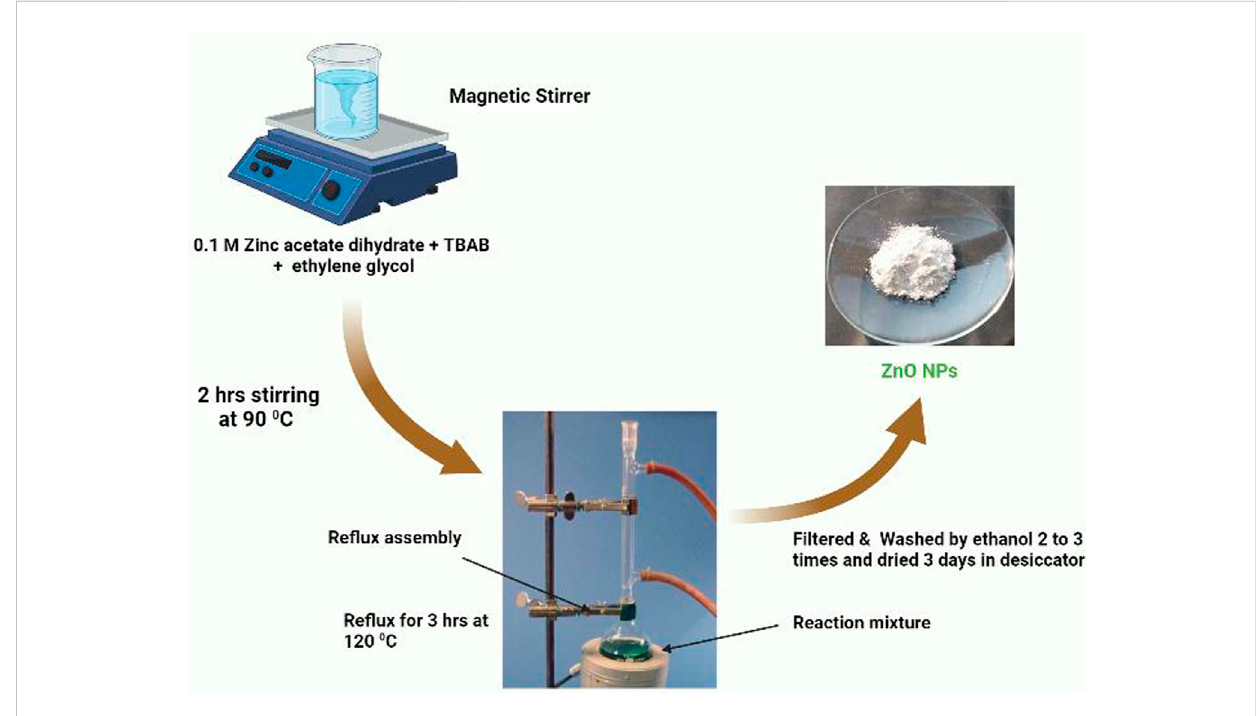
SCHEME 2 The synthesis process of polyol-mediated ZnO